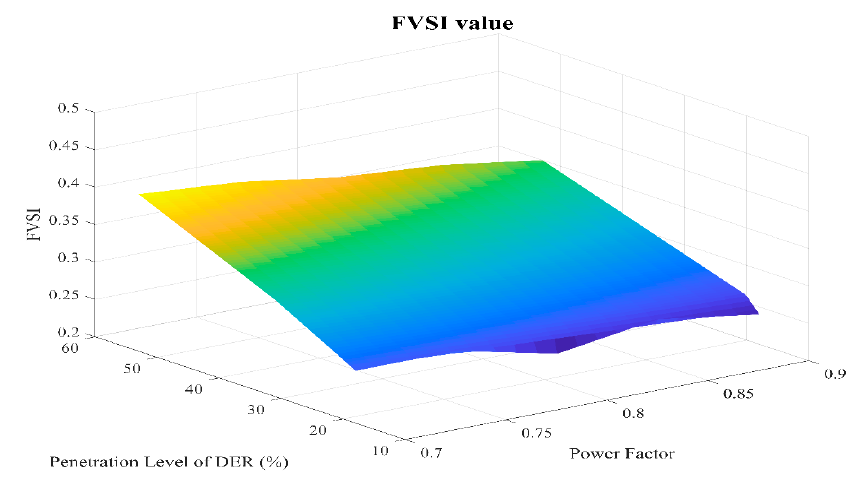
Figure 14. The FVSI for various power factors and penetration levels.